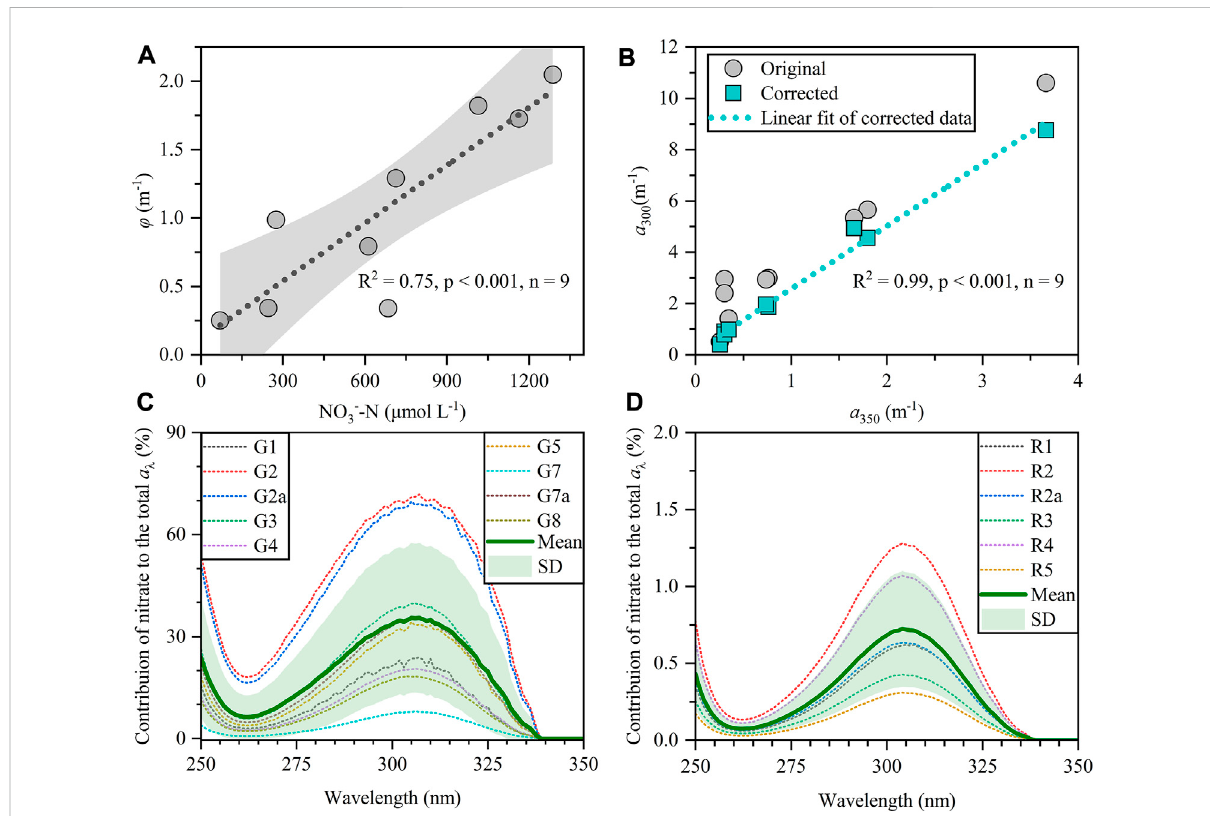
FIGURE 7 Relationships (A) between φ valuesandnitrateconcentrationsand (B) betweenoriginalandmodel-correctedabsorptioncoef fi cientsat300nm and 350 nm in groundwater samples, and the contribution of nitrate to the total absorption coef fi cient( a λ ) in (C) groundwater and (D) river water samples. Green solid lines and bands represent the mean values and standard deviations (SD),